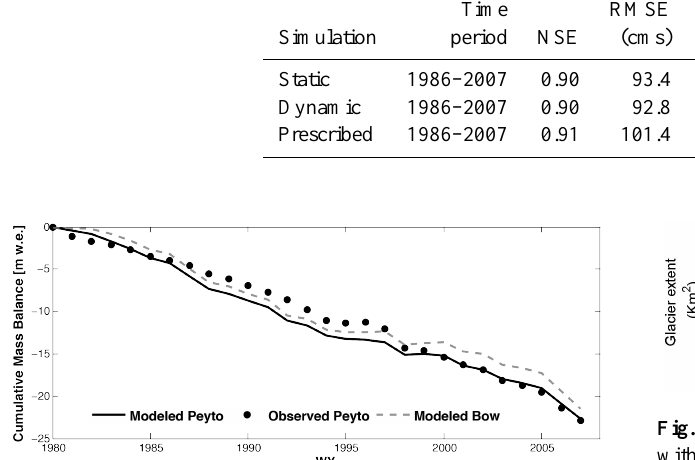
Fig. 10. Comparison of predicted cumulative glacier mass balance with observed measurements on Peyto glacier for the period of 1981–2007. Modeled cumulative mass balance for Bow glacier is also shown for comparison.